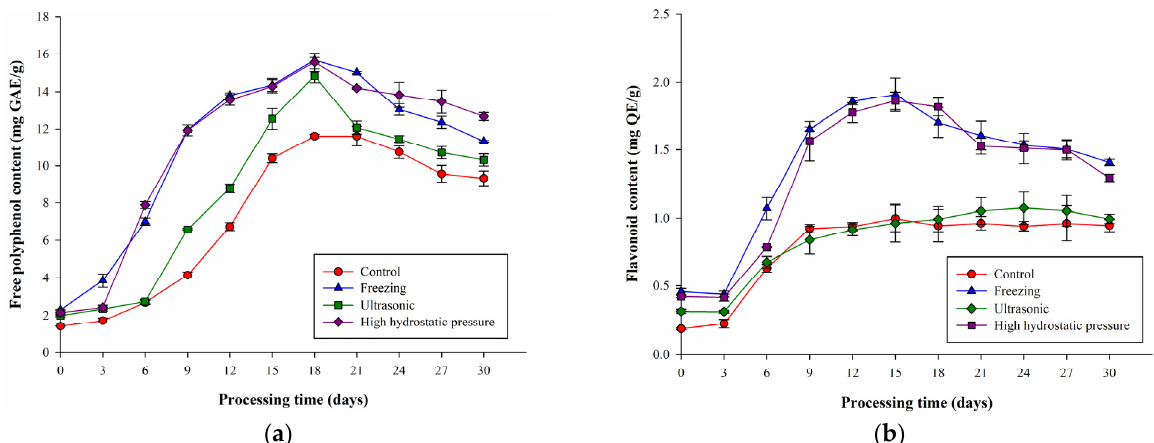
Figure 3. ( a ) Free polyphenol contents (mg GAE/g) and ( b ) flavonoid contents (mg QE/g dry weight) in garlic subjected to different pretreatment methods during thermal processing. All values are means ± standard deviations ( n = 3).